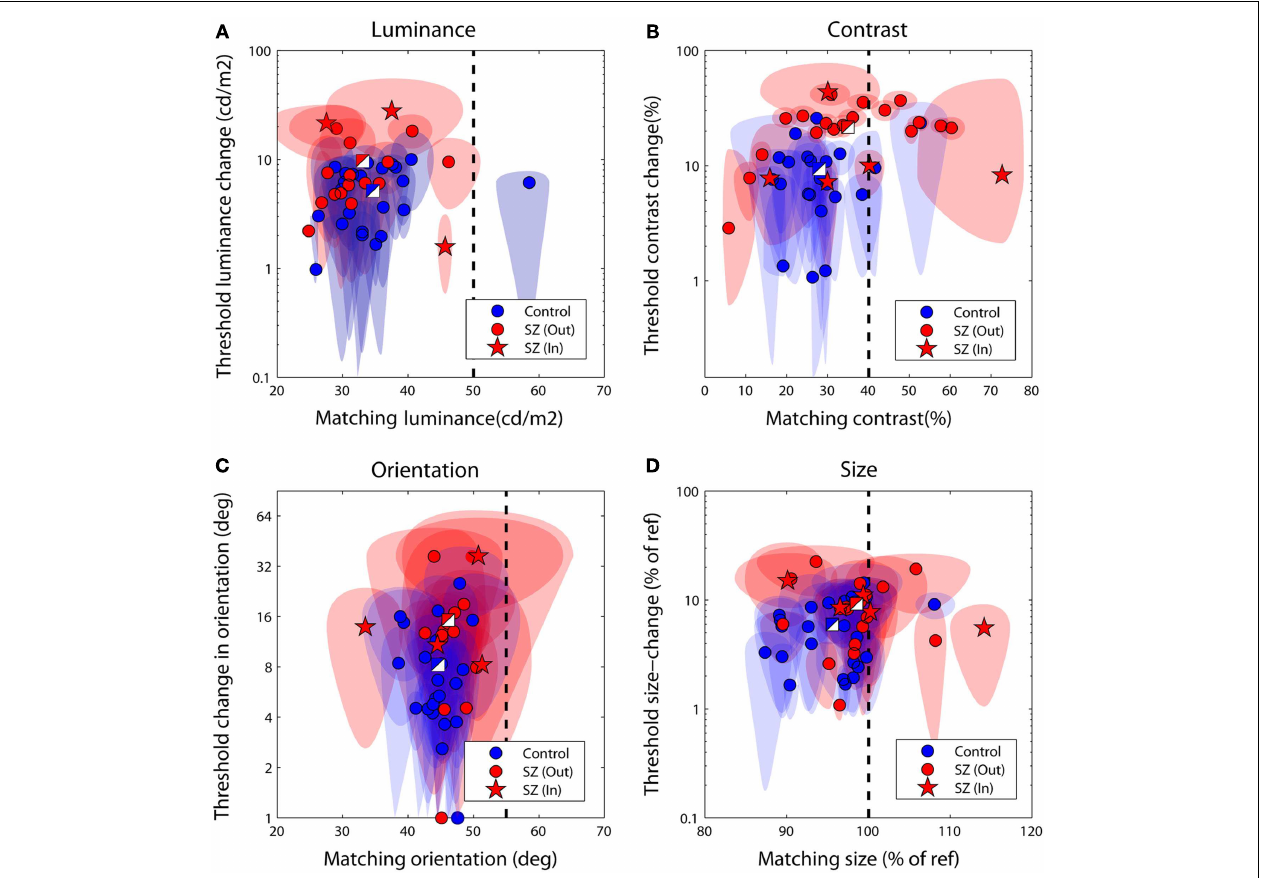
observers is plotted in blue, and of patients in red; two-toned squares show group averages. Ellipses denote 95% confidence intervals for parameter estimates.The vertical dotted line denotes a veridical (unbiased) match. Large negative biases reflect strong suppressive effects of the surround whilst larger threshold values (on the ordinate axis) reflect poorer performance. In, inpatients; Out,